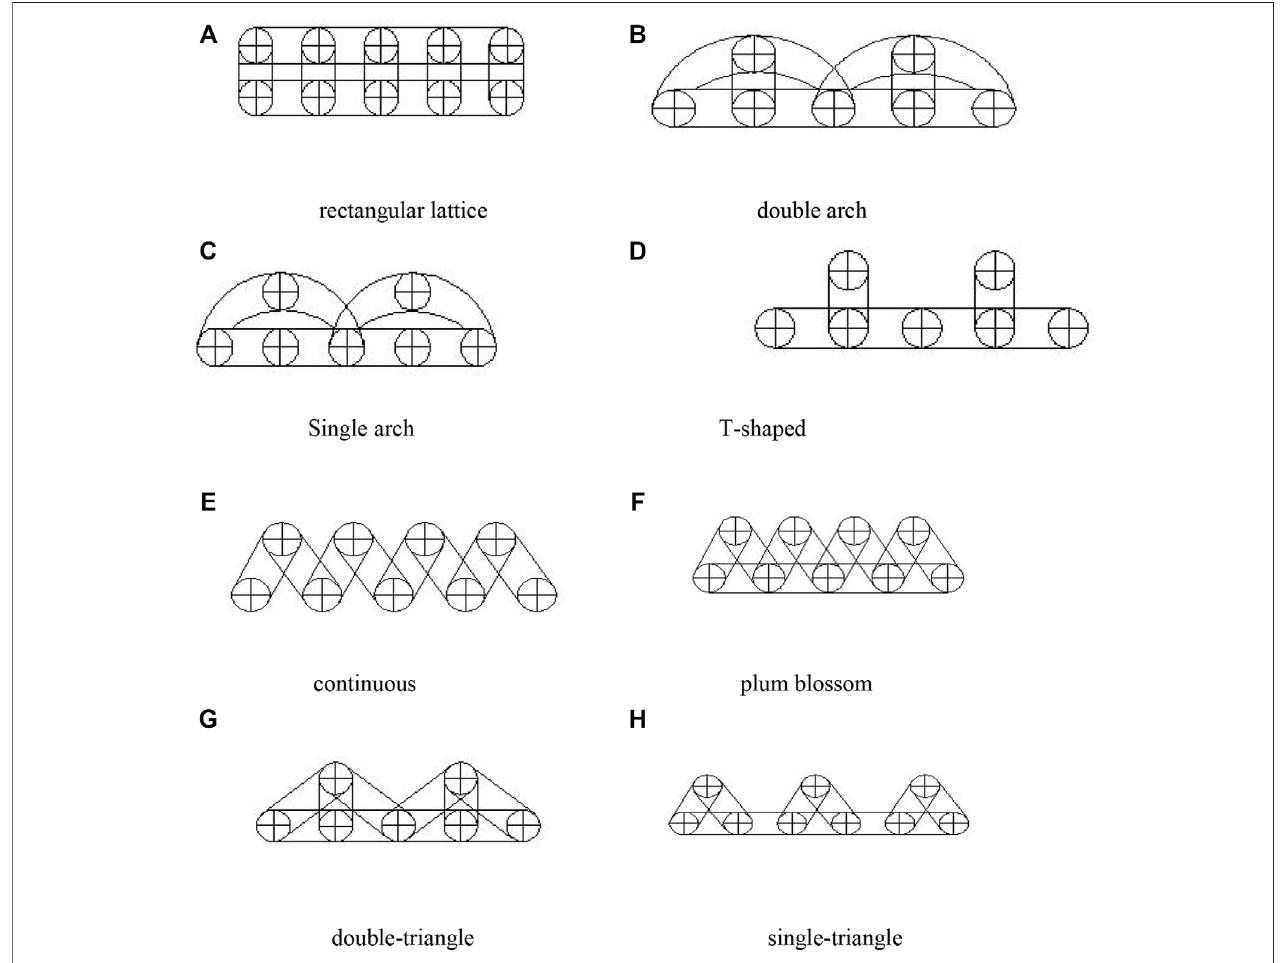
FIGURE 2 | Forms of double-row piles: (A) rectangular lattice, (B) double-arch, (C) single-arch, (D ) T-shaped, (E) continuous arch, (F) plum blossom, (G) double- triangle, and (H)